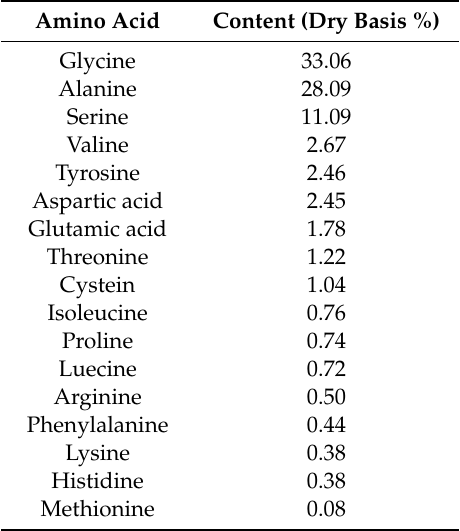
Table 3. Free amino acid composition of the protein component of the silk peptide. Amino Acid Content (Dry Basis %) Glycine 33.06 Alanine